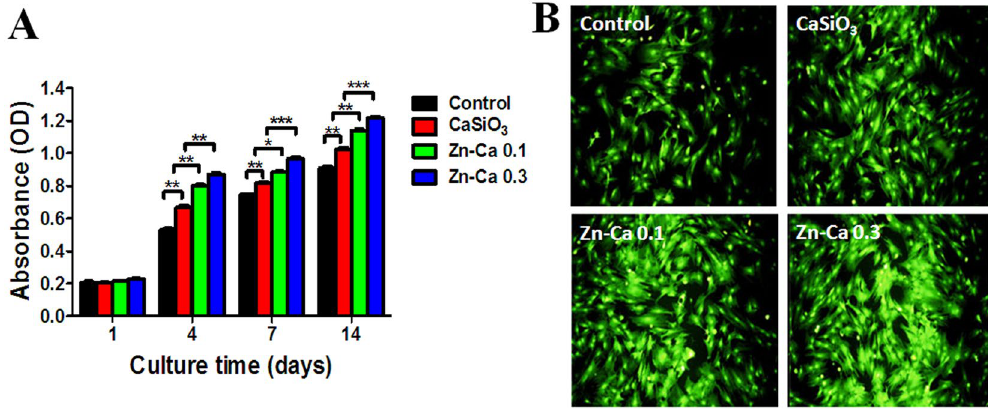
Figure 1. ( A ) BM-PCs proliferation on the Ti-6Al-4V (control) and the CaSiO 3 , Zn-Ca 0.1 and Zn-Ca 0.3 coating surfaces for 1, 4, 7 and 14 days as measured by a CCK-8 assay. ( B ) Cell cytotoxicity of BM-PCs cultured on different coatings at 48 h. Data are presented as the mean ± SD (n = 6). * p < 0.05, ** p < 0.01, *** p <